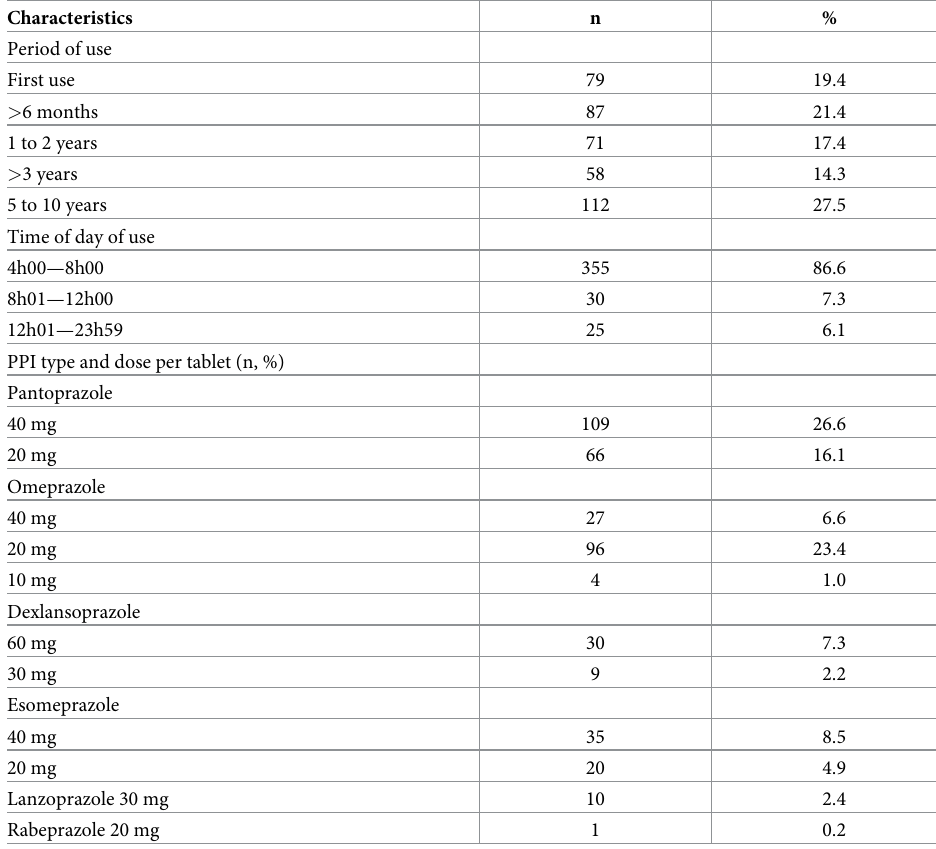
Table 2. PPI type and administration